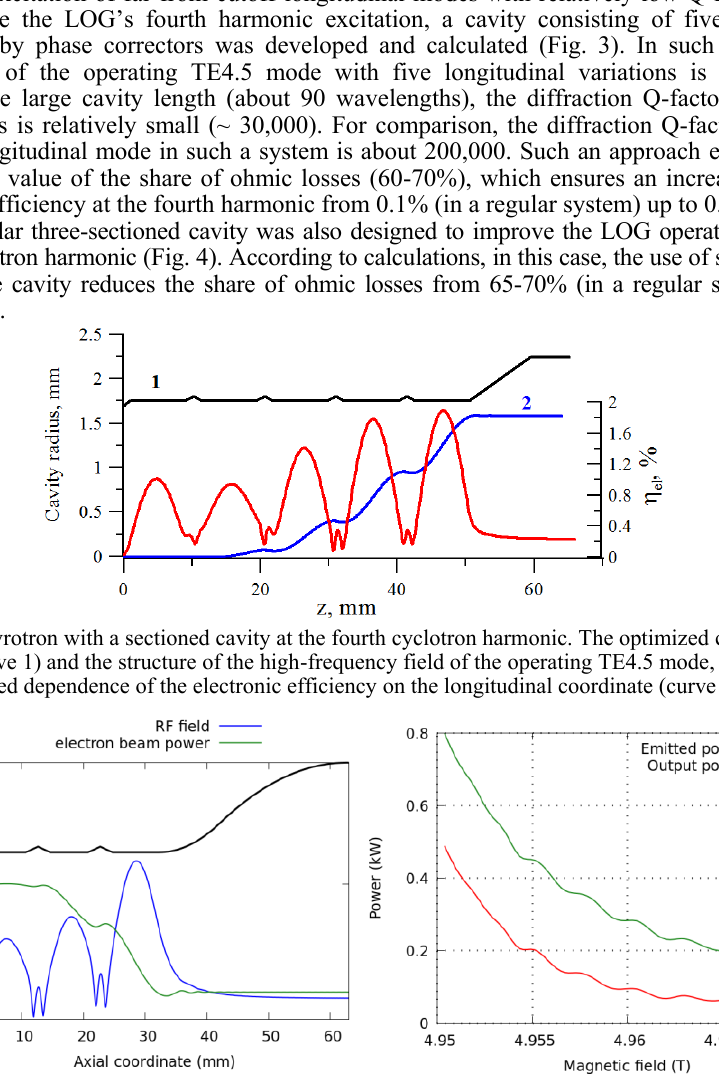
Fig. 4. A gyrotron with a sectioned resonator at the third cyclotron harmonic. The optimized cavity profile, the structure of the high-frequency field of the operating mode, and the calculated change in the electron beam energy with the longitudinal coordinate (a). Dependences of the power transmitted by the electron beam to the wave, as well as the power of the output radiation from the operating magnetic field